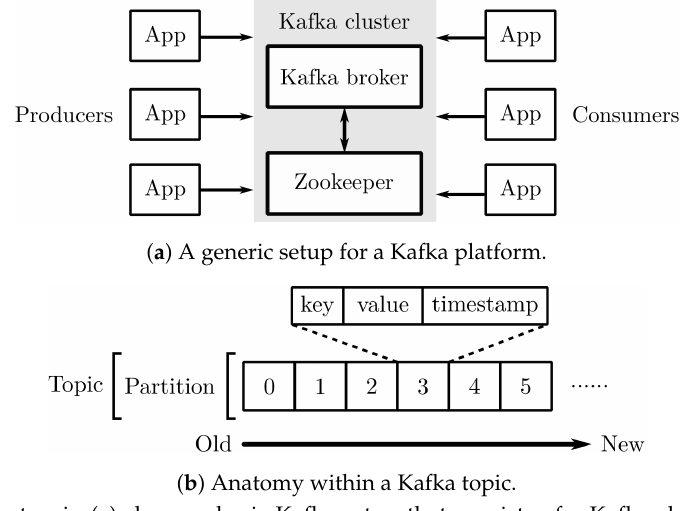
Figure 9. The setup in ( a ) shows a basic Kafka setup that consists of a Kafka cluster and clients. The Kafka cluster is comprised of a Kafka broker and a Zookeeper . Kafka clients either push (producers) or pull (consumers) data to or from a Kafka broker. The data are stored as immutable records within a Kafka topic, as shown in ( b